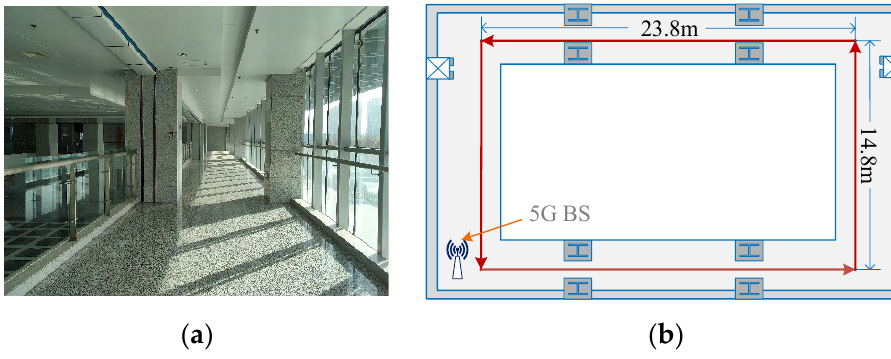
Figure 11. Covered corridor. ( a ) Scenario photograph. ( b ) Experimental approaches